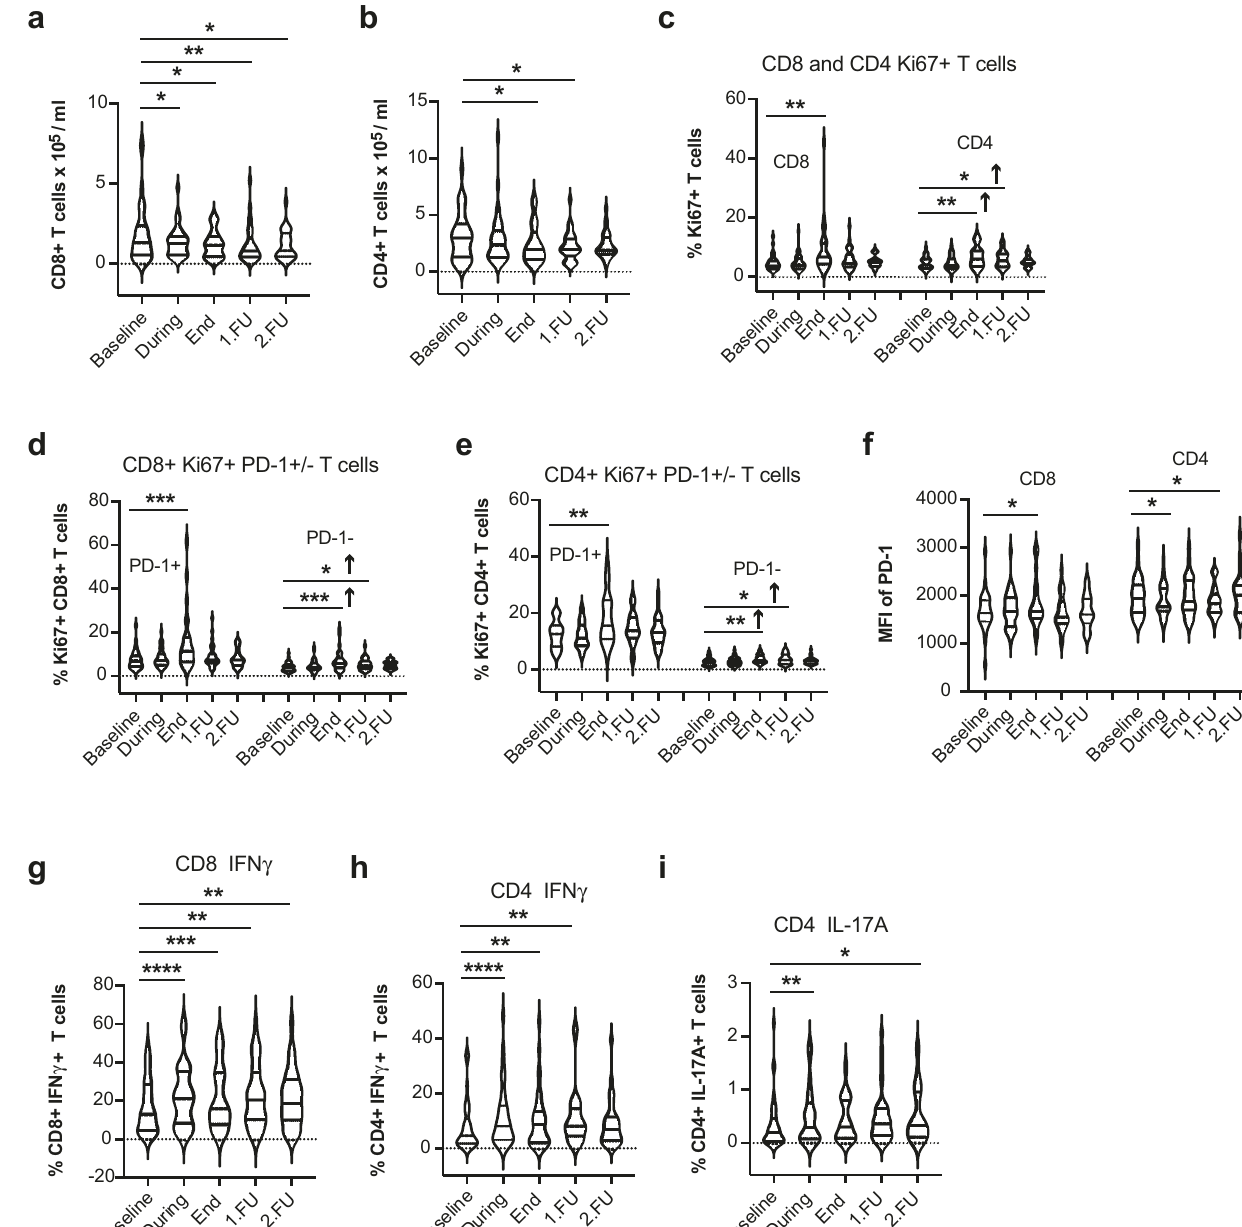
Fig. 1 Transient lymphodepletion during SBRT and increased proliferation of CD8 + and CD4 + circulating T-cells after SBRT in early-stage NSCLC patients. Absolute counts of CD8 + ( a ) and CD4 + circulating T-cells ( b ). Fractions of Ki-67 + CD8 + and Ki-67 + CD4 + T-cells ( c ), Ki67 + PD- 1 + / Ki67 + PD-1 − CD8 + T-cells ( d ), and Ki-67 + PD-1 + versus Ki-67 + PD-1 − CD4 + T-cells ( e ) during and after SBRT. f Median fl uorescence intensity (MFI) of PD-1 immunostaining for CD8 + and CD4 + T cells. Expression of IFN- γ in CD8 + T cells ( g ) and CD4 + T-cells ( h ), and expression of IL-17A in CD4 + T-cells upon re-stimulation ( i ). * p < 0.05, ** p < 0.01, *** p ≤ 0.001, **** p ≤ 0.0001 from mixed effects model for repeated measures with Geisser-Greenhouse correction and Benjamini, Krieger, and Yekutieli for the false discovery rate, two-sided. Arrows indicate the direction of change. Data are shown as median values (center lines) and interquartile